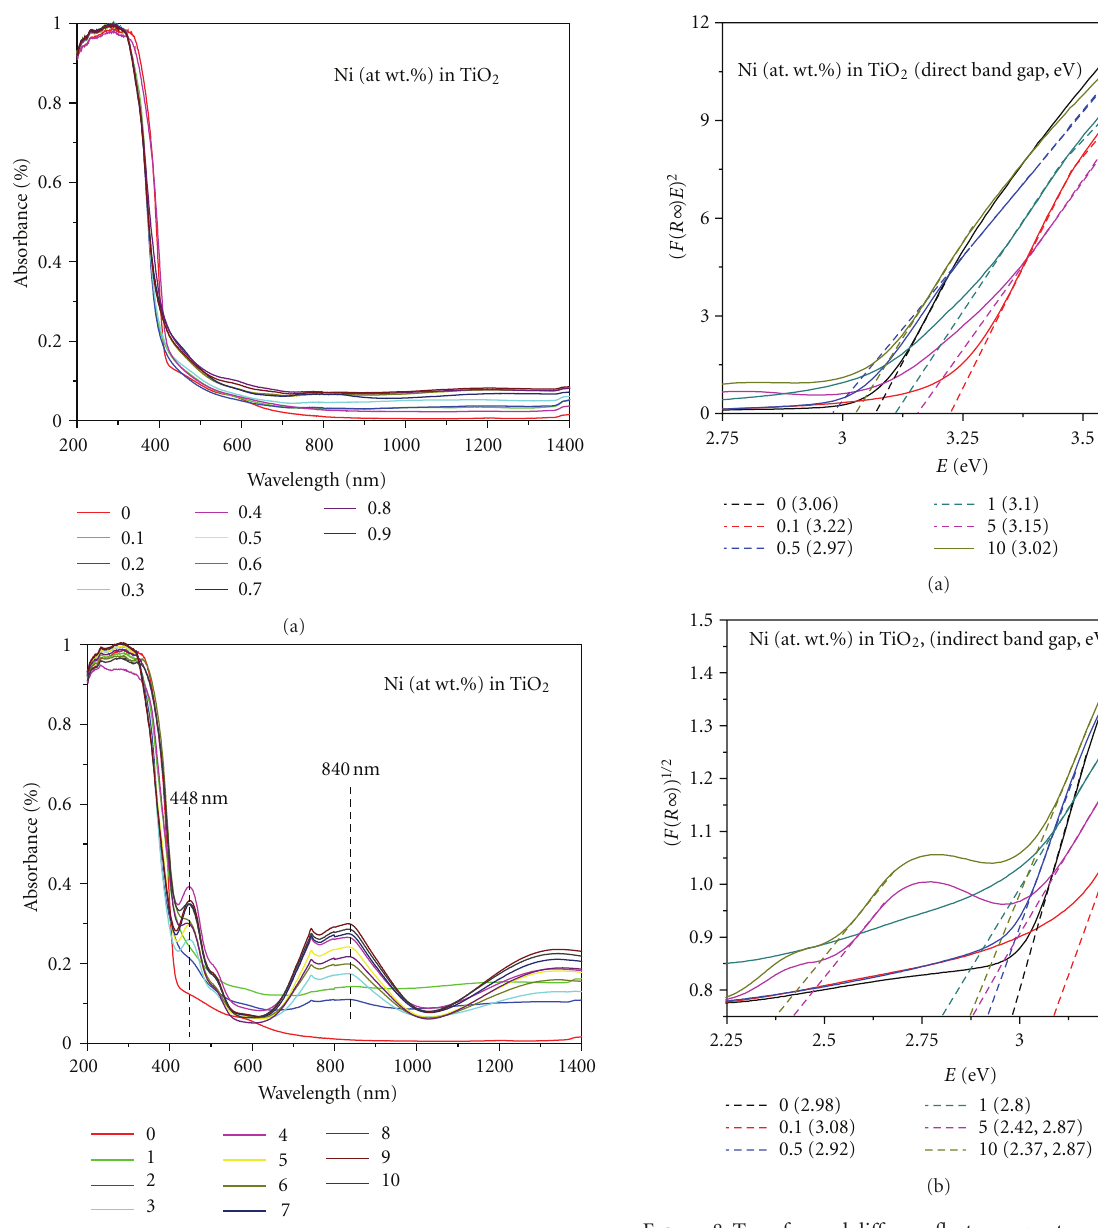
Figure 7: UV-Vis di ff use reflectance spectra (DRS) of Ni-doped TiO 2 (Ni = 0, 0.1 to 0.9 (a) and = 0, 1 to 10 at. wt.% (b)) powders formed at 550 ◦ C for 6h.